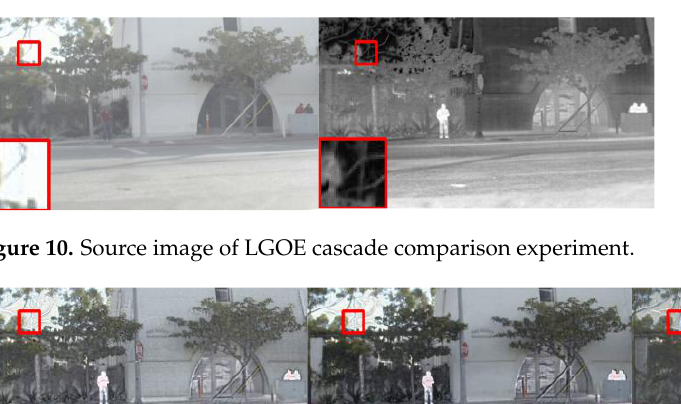
Figure 10. Source image of LGOE cascade comparison experiment.